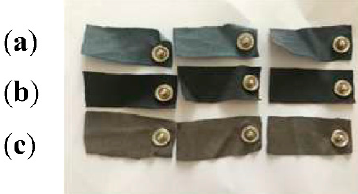
Figure 3. The shape of textile electrode used for ECG measurements; ( a ) 100% cotton; ( b ) cotton/Lycra; ( c ) silver-plated.